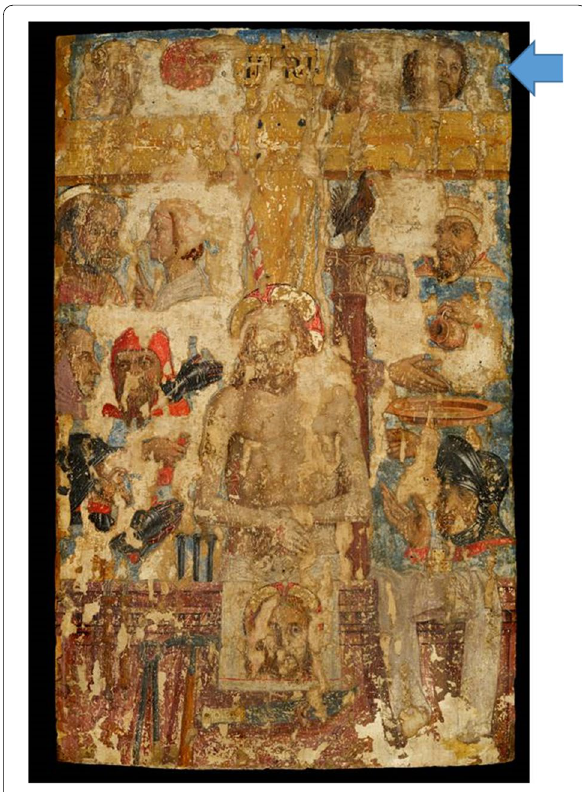
Fig. 2 Morone’s painting with the area where the blue paint fragment was taken indicated by an